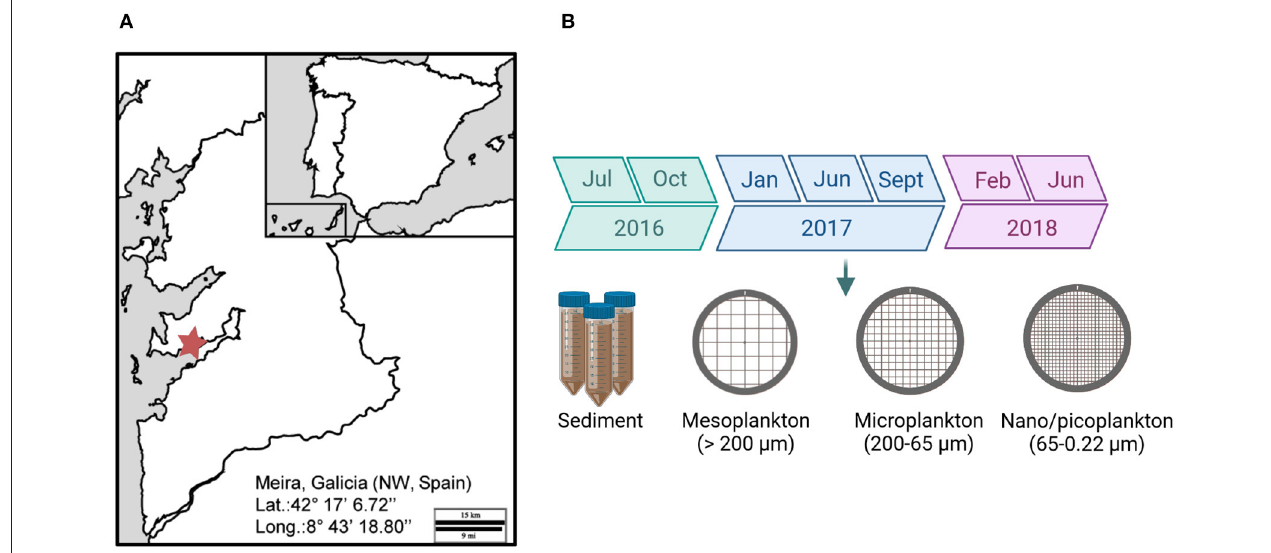
FIGURE 1 | (A) Location of the bivalve production area in the Ría of Vigo (Meira, NW, Spain). (B) The sampling period extended from 2016 to 2018. Environmental samples were collected for analysis.